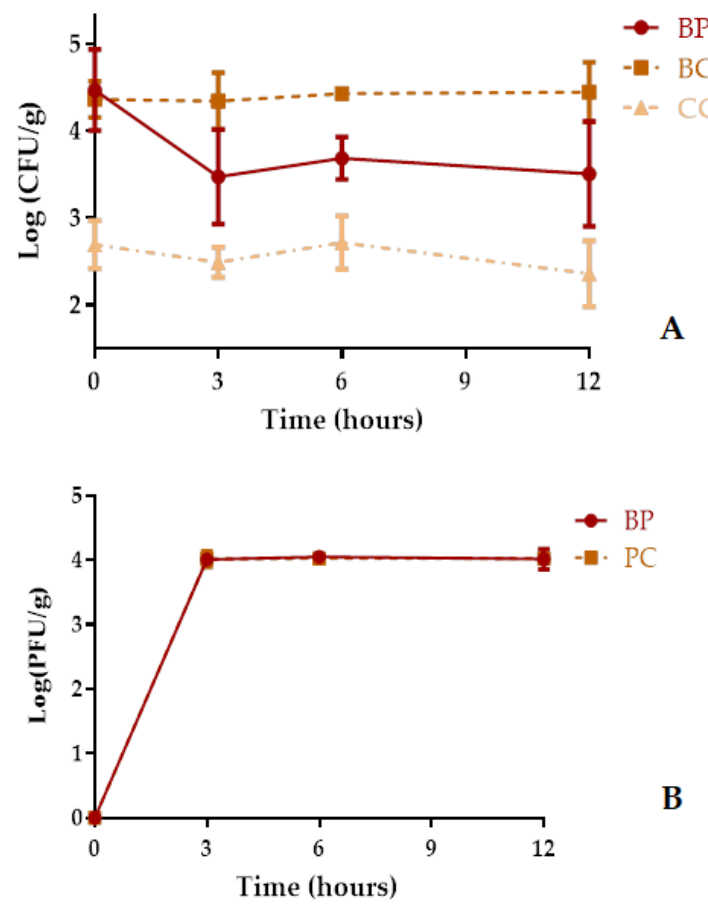
Figure 7. Inactivation of A. hydrophila in artificially contaminated cockles using phage AH-1 at a MOI of 1 during 12 h. ( A ) Bacterial concentration: CC, uninfected group (control cockles); BC, bacteria control; BP, bacteria plus phage. ( B ) Phage concentration: PC, phage control; BP, bacteria plus phage. Values represent the mean of the three experiments and error bars represent the standard deviation.